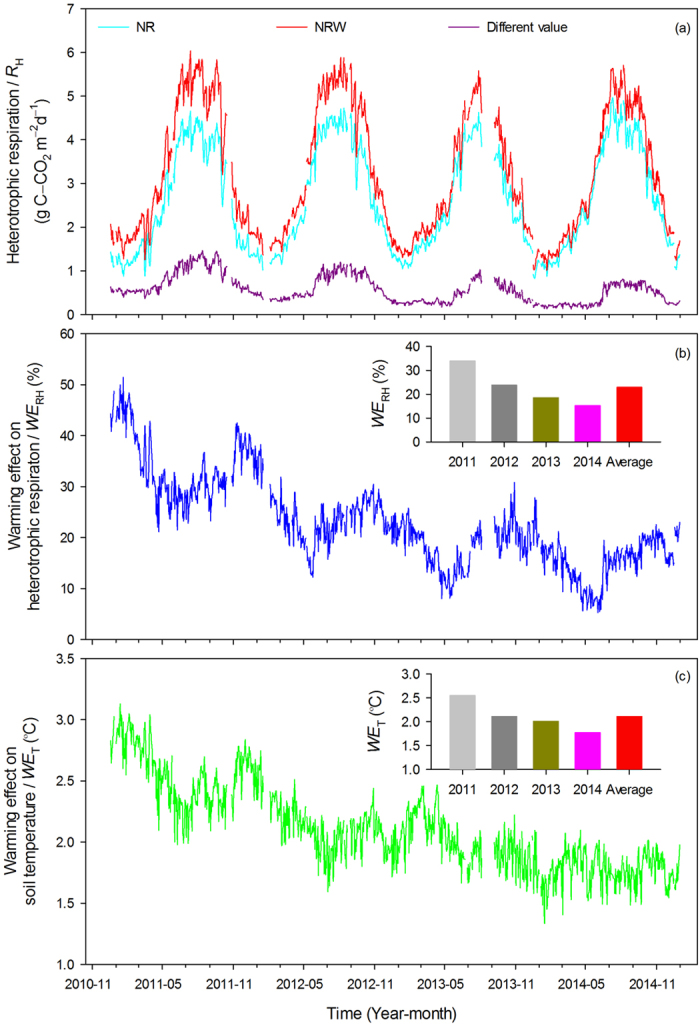
Variation of heterotrophic respiration in warmed (NRW) and unwarmed (NR) treatments and their difference (RNRW − RNR) (a), the variation of the warming effect on heterotrophic respiration (WERH) (b), and the variation of the warming effect on soil temperature (WET) (c).